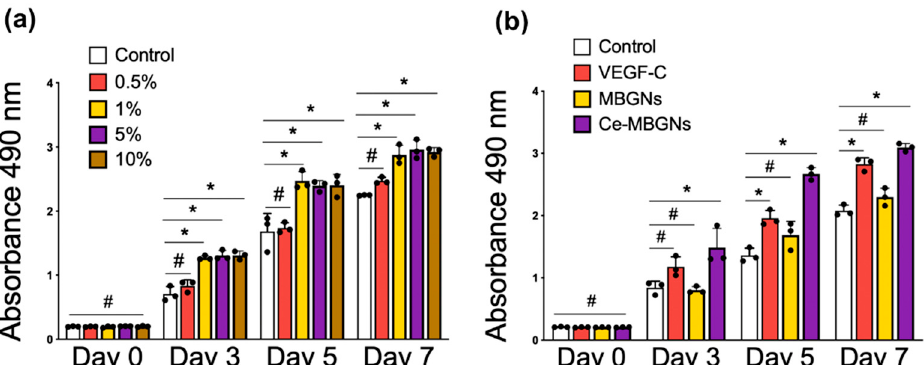
Figure 2. CCK-8 assay results of ( a ) LECs cultured with the conditioned media of Ce-MBGNs (0, 0.5, 1, 5, 10 wt/v% extract) and ( b ) LECs cultured with conditioned media of VEGF-C (50 ng/mL), MBGNs (1 wt/v% extract), and Ce-MBGNs (1 wt/v% extract). The experiment was performed at least in triplicate independently. Three technical repeats were used within each experiment that was repeated in triplicate. Data are presented as mean ± S.D. p < 0.05 (*) and p > 0.05 (#).